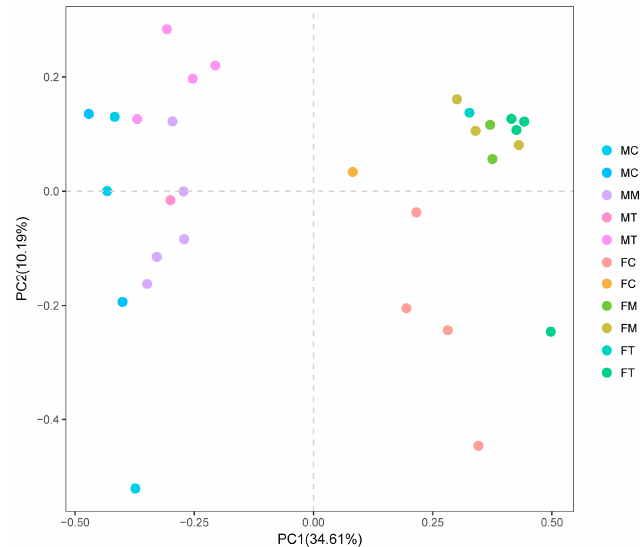
Figure 5. PCA plot of the Morisita–Horn dissimilarity matrix. PCA denotes principal component analysis.